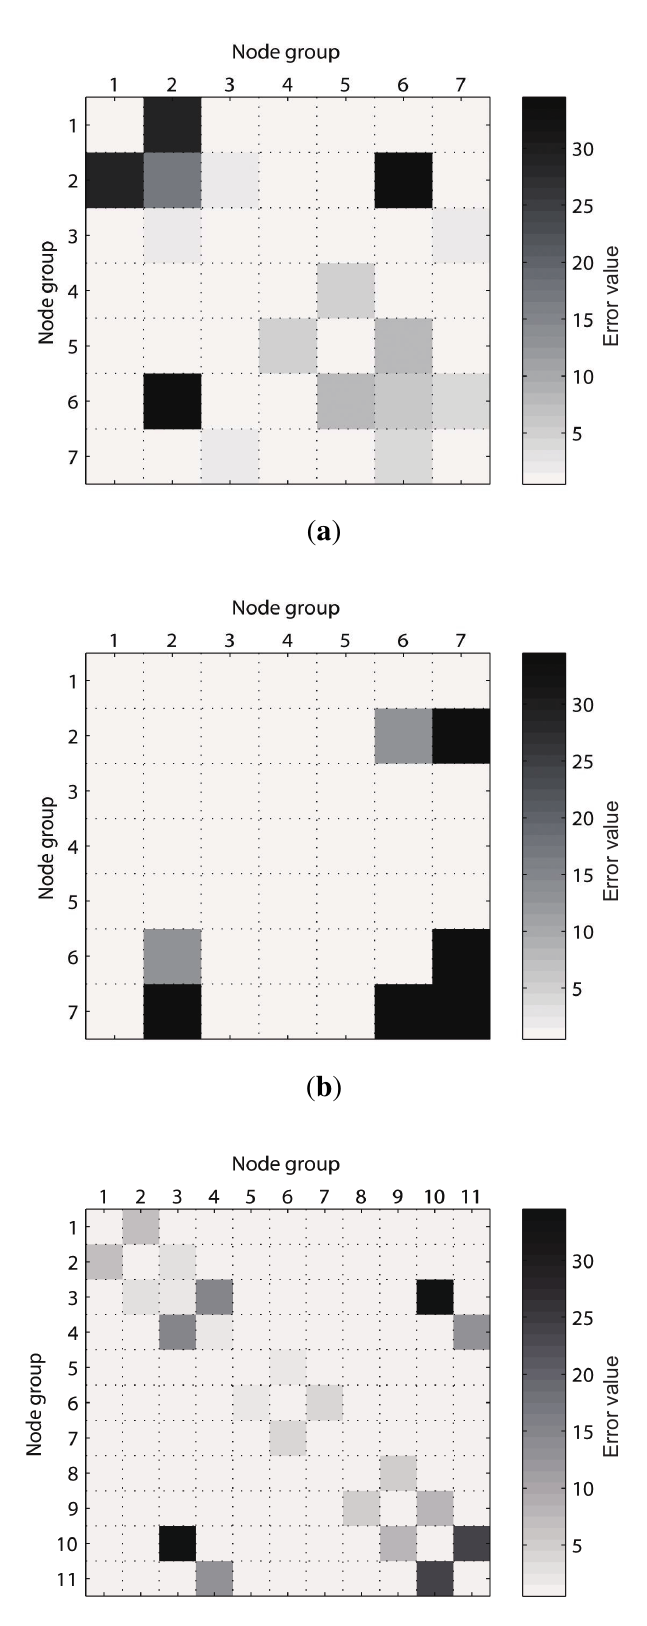
Figure 22. Error metrics for the node groups at the moment of movement detection in low dynamic environments. ( a ) Experiment 1; ( b ) Experiment 2; ( c ) By object 1 in experiment 3; ( d ) By object 2 in experiment